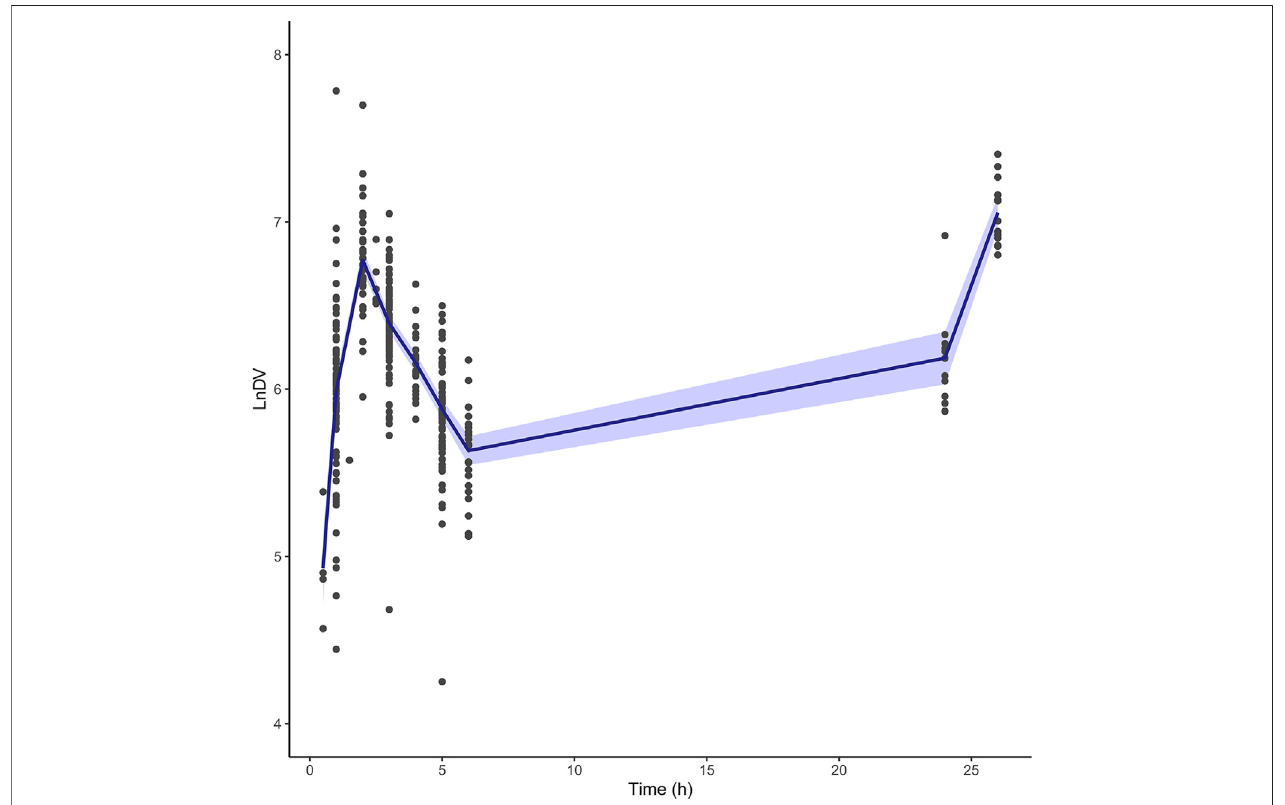
FIGURE 6 | The LnDV vs. Time plot for external dataset. The middle solid blue line represents the mean LnDV. The semitransparent fi elds represent a 90% con fi dence interval for the mean.